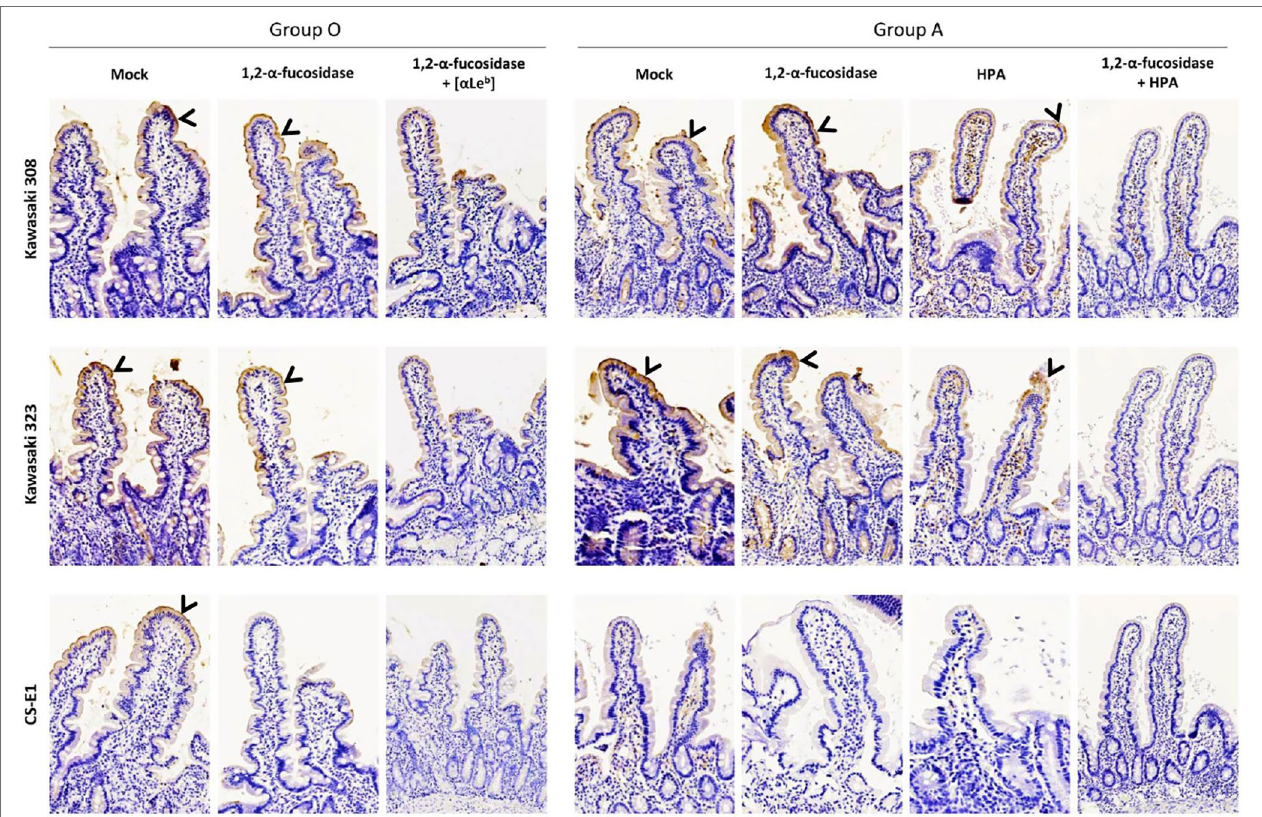
FIGURE 8 | Histological analysis on duodenal sections of GII.17 recognized by HBGA. Duodenal tissue samples from group O and A individuals were used for VLP binding assays and competition experiments where sections were singly or concomitantly incubated with 1,2- α -L-fucosidase, Le b -specific mAb (anti-Le b ) and HPA. Patient blood group and GII.17 variant are indicated above the panel series. For the competition experiments, fucosidase, mAb, and lectin are indicated on the left side of each panel series. Positive VLP detection is featured by brown staining and indicated by arrowheads on all